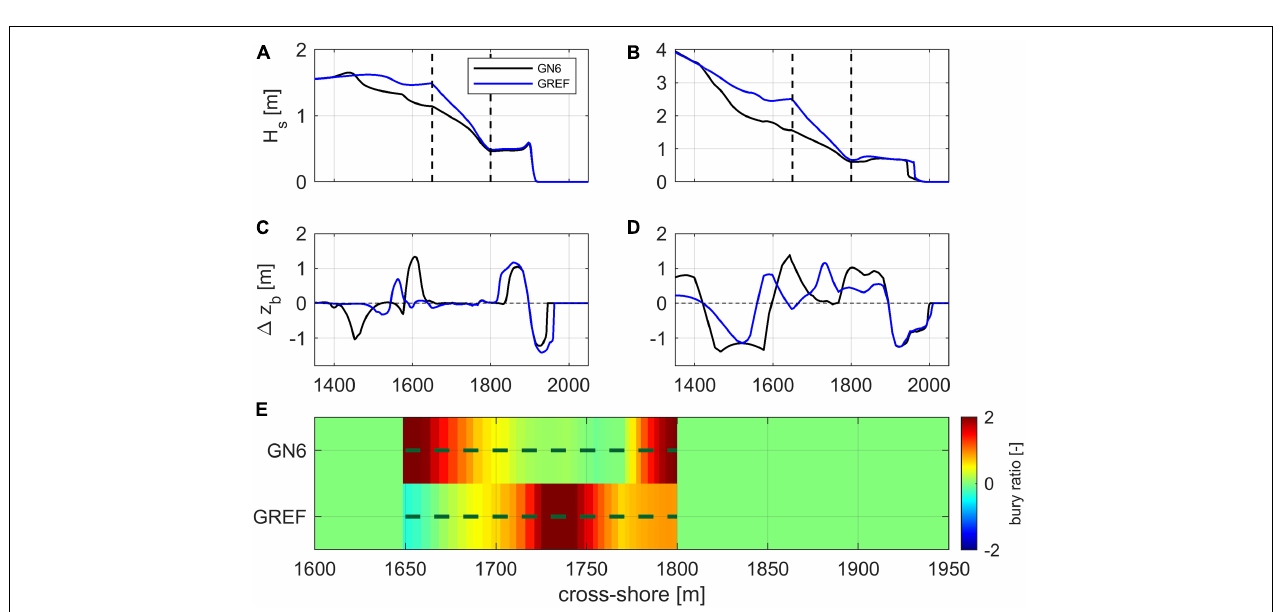
FIGURE 15 | Comparison of case GN6 and GREF, showing: (A) wave height profile under mild wave condition on initial bed profile; (B) wave height profile under storm wave condition on pre-storm profile; (C) seabed change at the end of 100 days simulation; (D) seabed change at the end of storm event; (E) bury analysis for seagrass